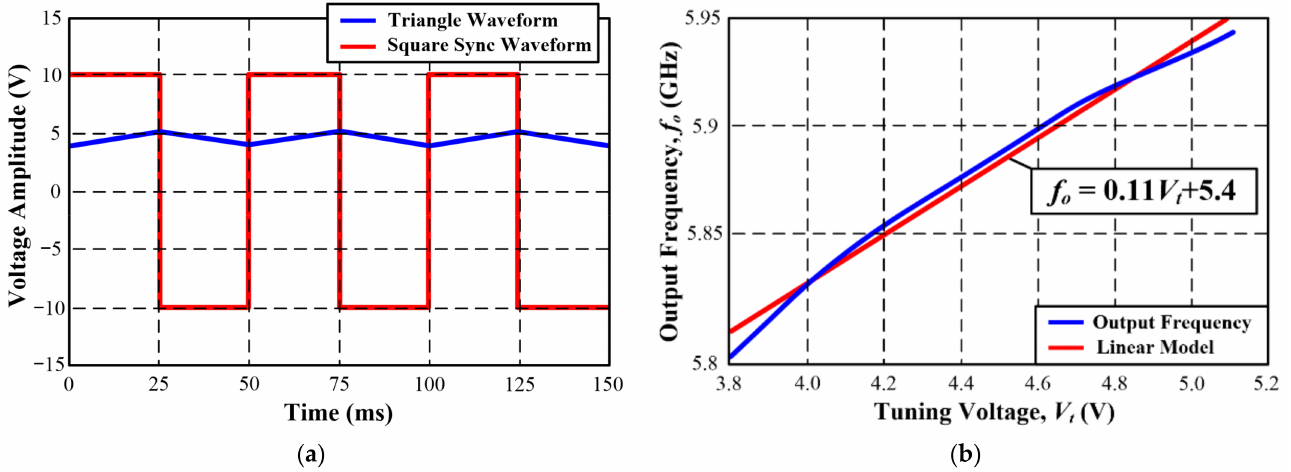
Figure 3. Variation trends concerning ( a ) output signals obtained from proposed modulator and ( b ) VCO output